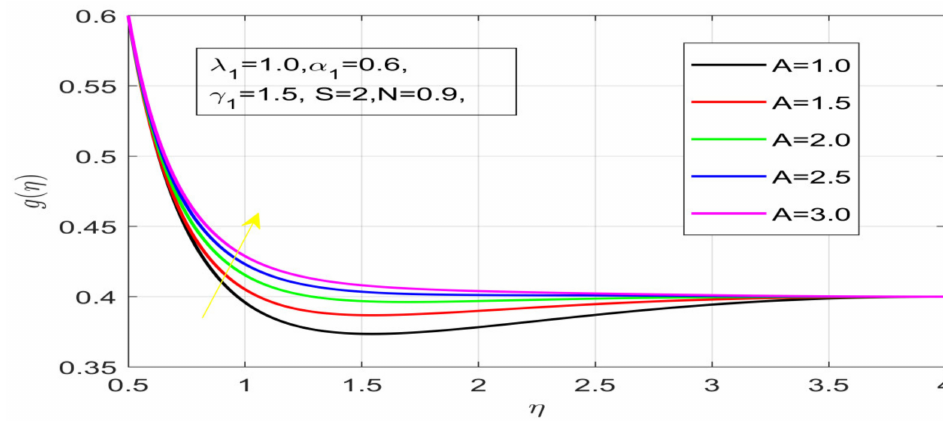
Figure 7. Effect of A on azimuthal